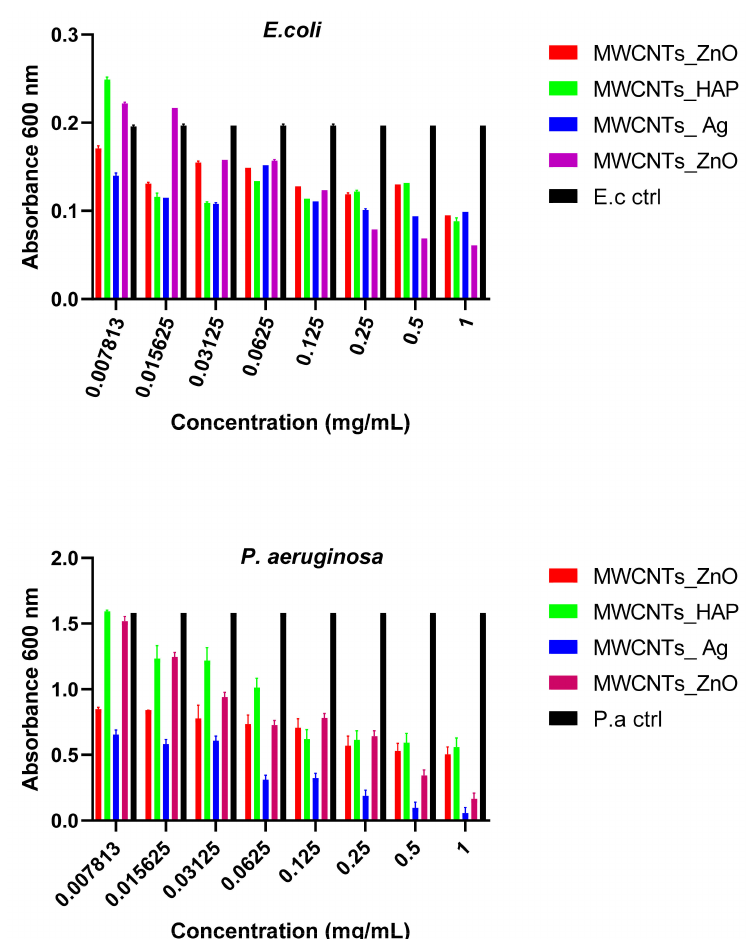
Figure 12. Graphical representation of the minimum concentration for eradication of biofilm for MWCNTs and decorated MWCNTs on Gram-negative strains. Data represented were mean of triplicate values with standard